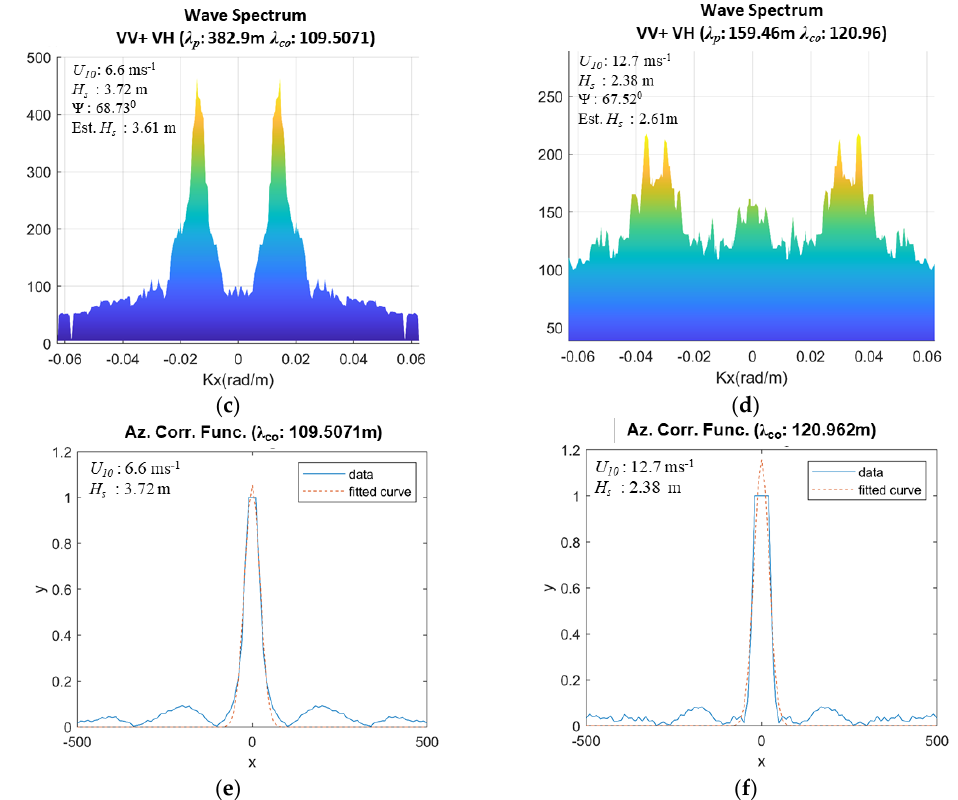
Figure 3. Averages over the range (x-axis) of the 2-D wavenumber spectra of VV NRCS ( a ) and composite polarization NRCS ( c ) on 27 March 2017, and averages over the range (x-axis) of the 2-D wavenumber spectra of VV NRCS ( b ) and composite polarization NRCS ( d ) on 26 April 2017, The azimuth correlation functions of the composite polarization NRCS on 27 March 2017 ( e ) and 26 April 2017 ( f ). Table 2. Comparison of results between SAR images and NDBC buoy data based on the cases of Figure 2 ( ΔH s = Est. H s - Buoy H s ).